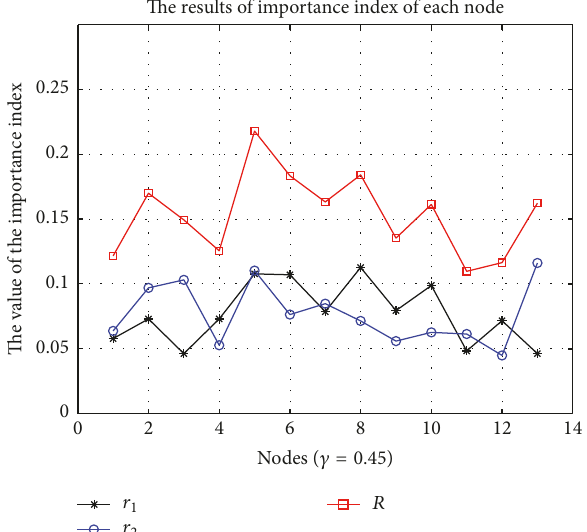
Figure 3: The values of the importance index of nodes when 𝛾 = 0.45 .